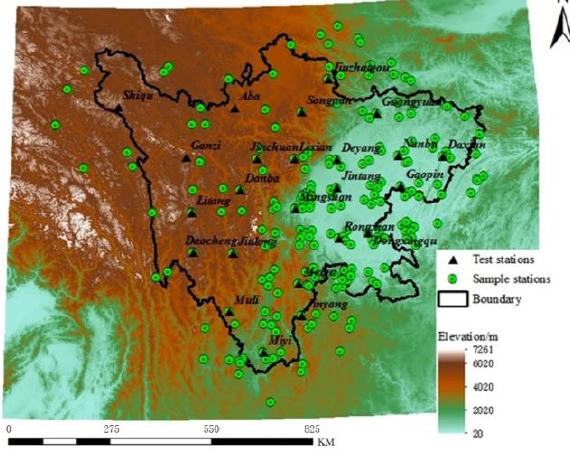
Figure 1. Distribution of meteorological